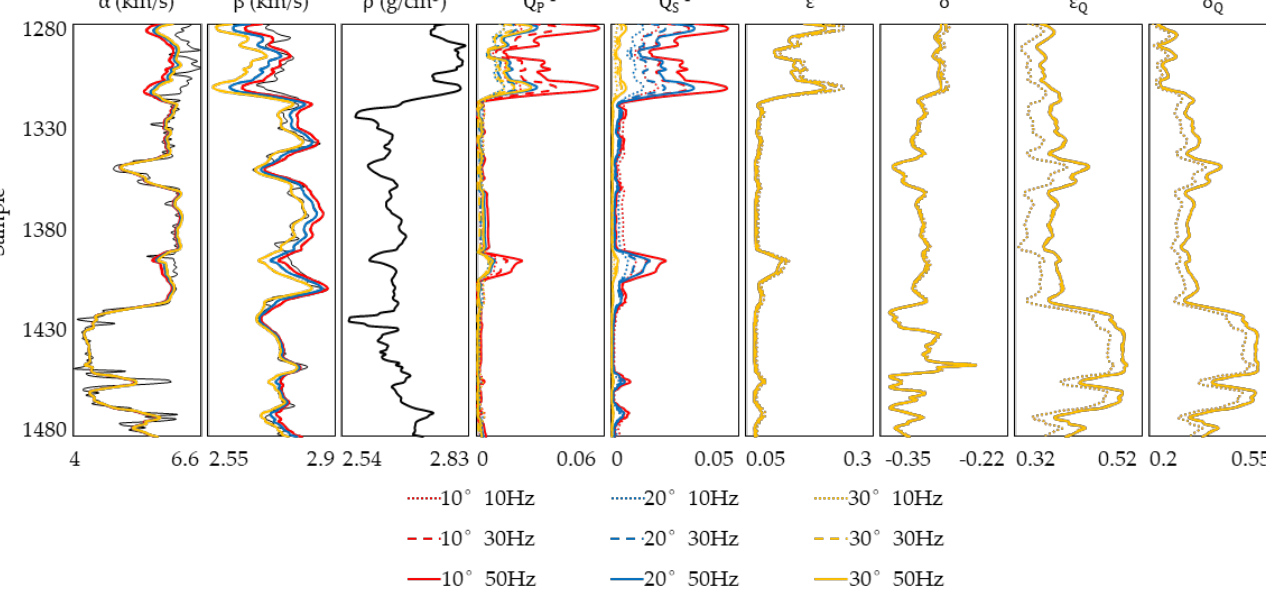
Figure 7. The estimated results of the attenuated and anisotropic parameters using Chapman model in different frequency and incident angle. The black lines are the measured values from well-logging.